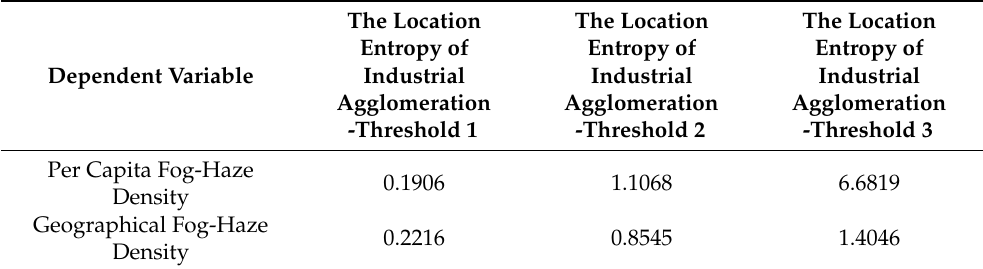
Table 8. Threshold estimation.